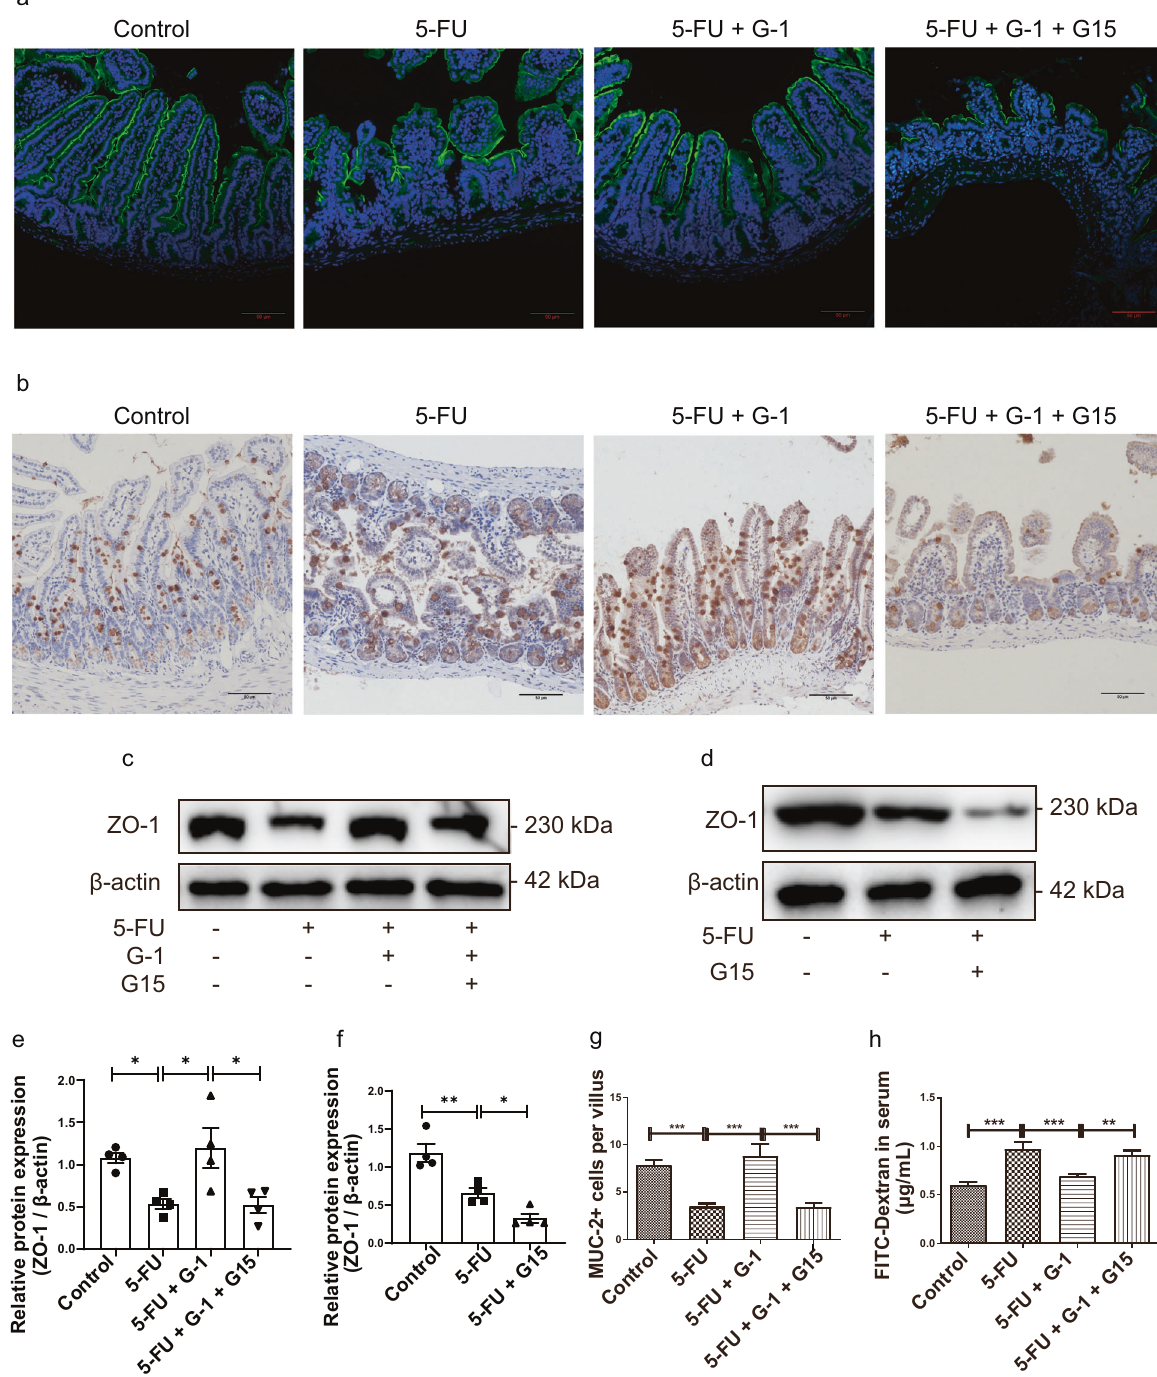
Fig. 2 Effect of GPER on the intestinal mucosal barrier in 5-FU induced CIM. CIM model was induced by i.p. injection 5-FU (30 mg/kg/day) for 5 days. G-1 (0.03 mg/kg/day), G15 (0.3 mg/kg/day) were administrated intraperitoneally with 5-FU together. G-1 was administrated alone or with G15 in CIM model to test the effect of GPER activation. G15 was used alone to test the effect of endogenous GPER blocking. On the 5 th day, the ileum was collected for immuno fl uorescence, immunohistochemical staining and western blot. Data were expressed as mean ± SEM (* P < 0.05, ** P < 0.01, *** P < 0.001). a Immuno fl uorescence for ZO-1 in ileum to show the effect of G-1 on ZO-1 expression in the CIM model (scale bars: 50 μ m). b Representative images for immunohistochemical staining of Muc-2 in ileum following G-1 administration with or without G15 in the CIM model (scale bars: 50 μ m). c Representative western blots photographs for ZO-1 following G-1 administration with or without G15 in the CIM model. d Representative western blots photographs for ZO-1 following endogenous GPER blocking with G15 alone in the CIM model. e Statistical analysis of ZO-1 expression in ileum tissue within four subgroups to show the effect of GPER activation on ZO-1 expression in the CIM model ( n = 4). f Statistical analysis of ZO-1 expression in ileum tissue within three subgroups to show the effect of endogenous GPER blocking on ZO-1 expression in the CIM model ( n = 4). g Effect of GPER activation on the number of Muc-2 + cells per villus within four subgroups in the CIM model. At least 20 villi were counted randomly for each slide, and the mean value was calculated for single sample ( n = 6). h Effect of GPER activation with G-1 on ileal mucosal permeability within four subgroups in the CIM model ( n =